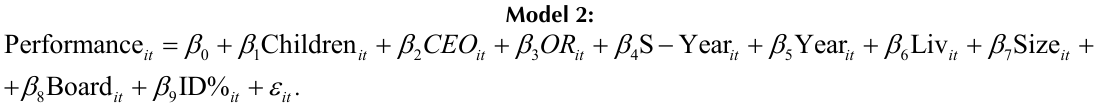
Table 3. Regression analysis: successor and corporate performance